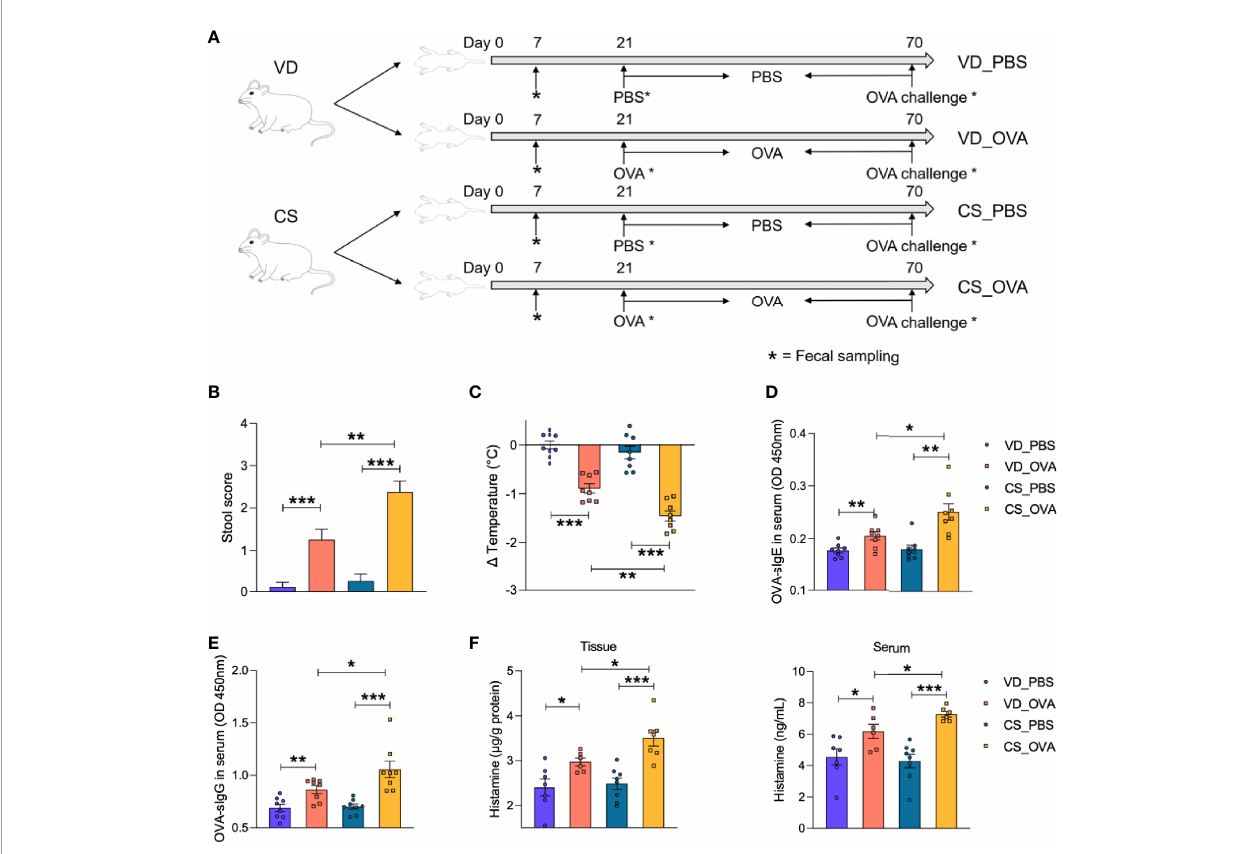
FIGURE 1 | CS increases disease severity in OVA-induced food allergy. (A) Schematic diagram of VD and CS rats submitted to food allergy. (B) The severity of allergic diarrhea was judged by stool score. (VD_PBS n = 9, VD_OVA n = 8, CS_PBS n = 8, CS_OVA n = 8). (C) Changes in rectal temperature at 25 min after challenge (VD_PBS n = 9, VD_OVA n = 8, CS_PBS n = 8, CS_OVA n = 8). (D, E) OD 450 was used to indicate the relative OVA-speci fi c IgE (D) and IgG (E) levels in the serum. n = 8. (F) Histamine level in the ileum or serum measured by ELISA. n ≥ 6. For (B) , bars represent meanand SEM. For (C – F) , circles and squares represent individual rats, and bars represent mean ± SEM. Statistical signi fi cance was determined by two-sided Student ’ s t-test or one way ANOVA, * P < 0.05, ** P < 0.01, *** P < 0.001. VD, vaginal delivery; CS, cesarean